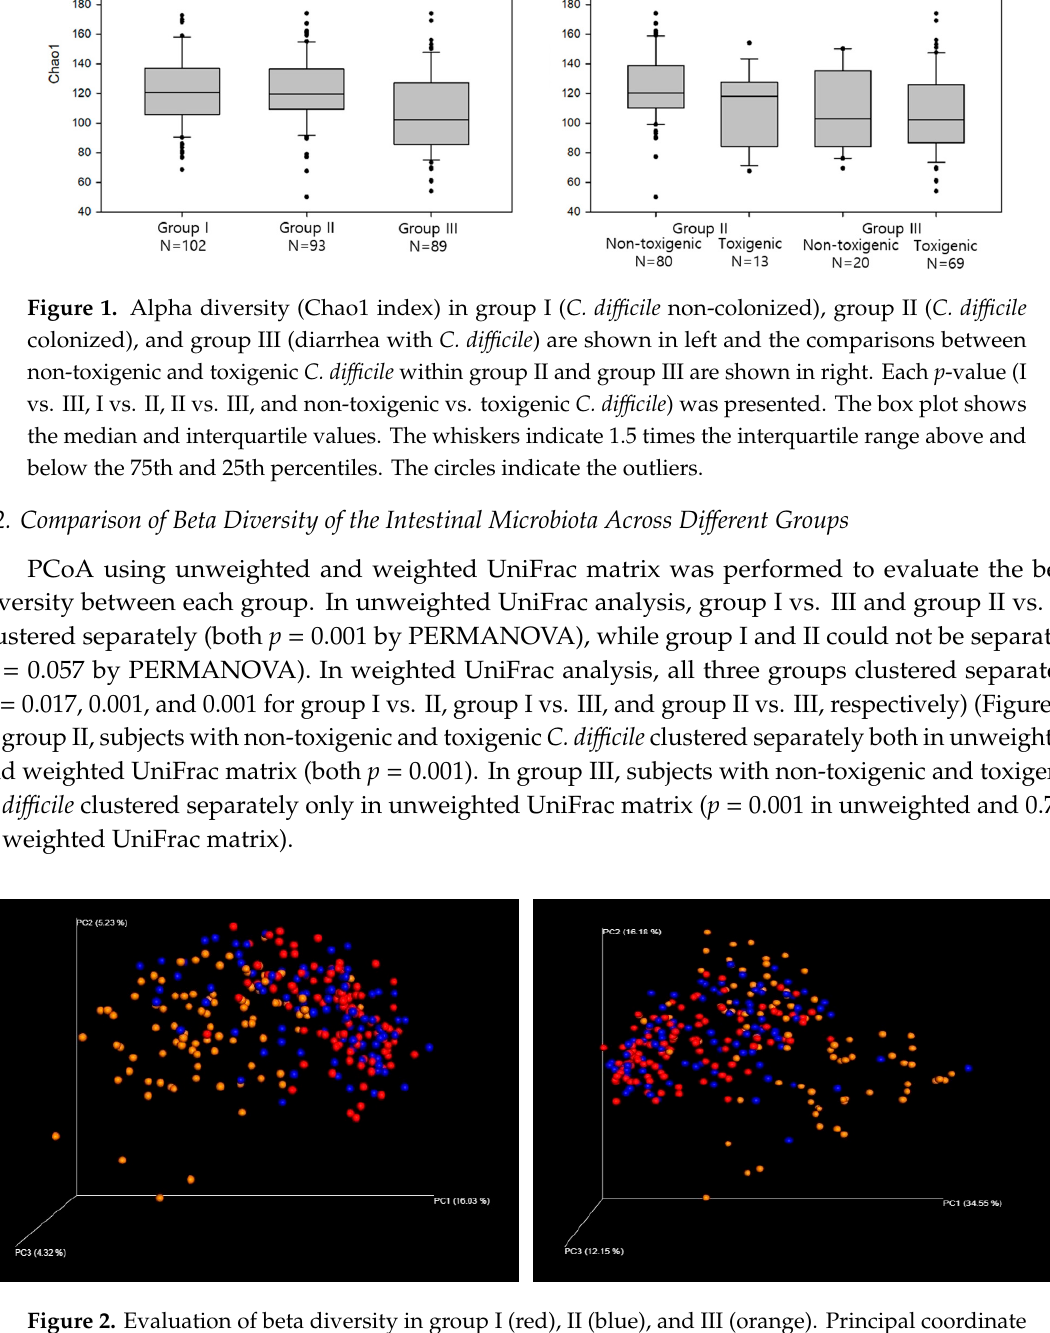
Figure 2. Evaluation of beta diversity in group I (red), II (blue), and III (orange). Principal coordinate analysis (PCoA) was performed using unweighted (left) and weighted (right) UniFrac distances of 16S rRNA gene sequences. Each axis represents inter-sample